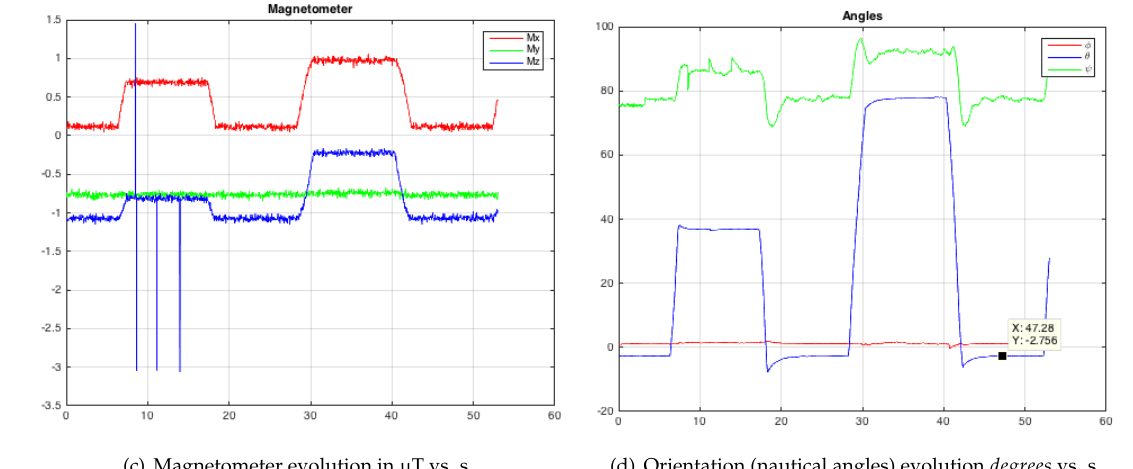
Figure 7. Test 2—Modifying the pitch angle ( θ